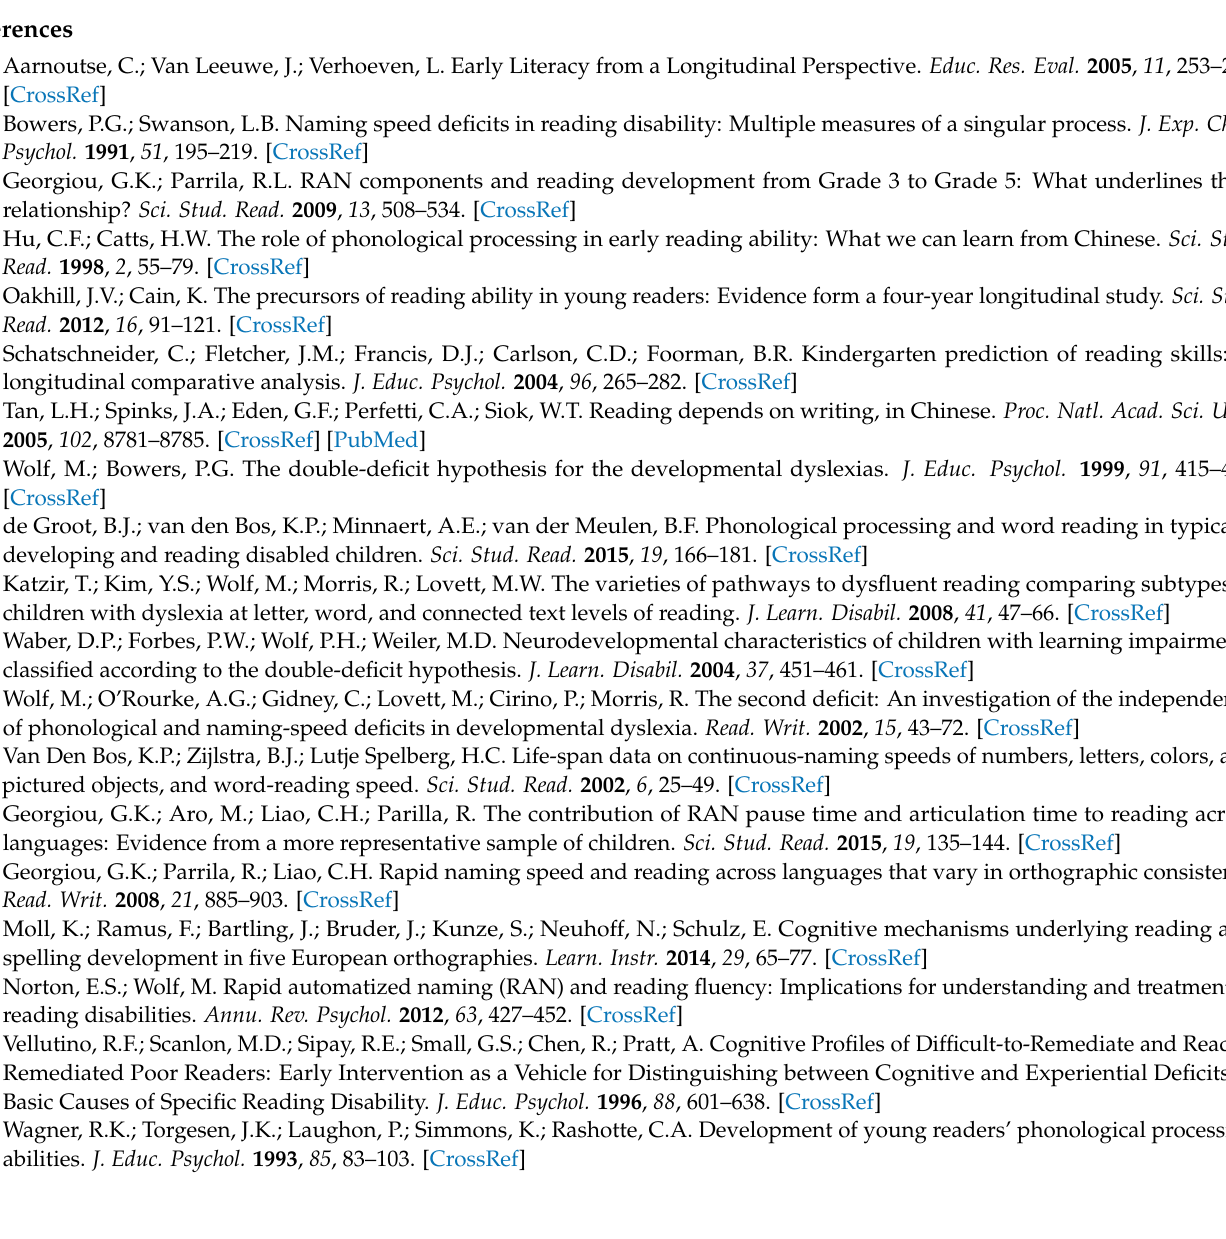
Figure A3. Serial Digit Rapid Automatized Naming.